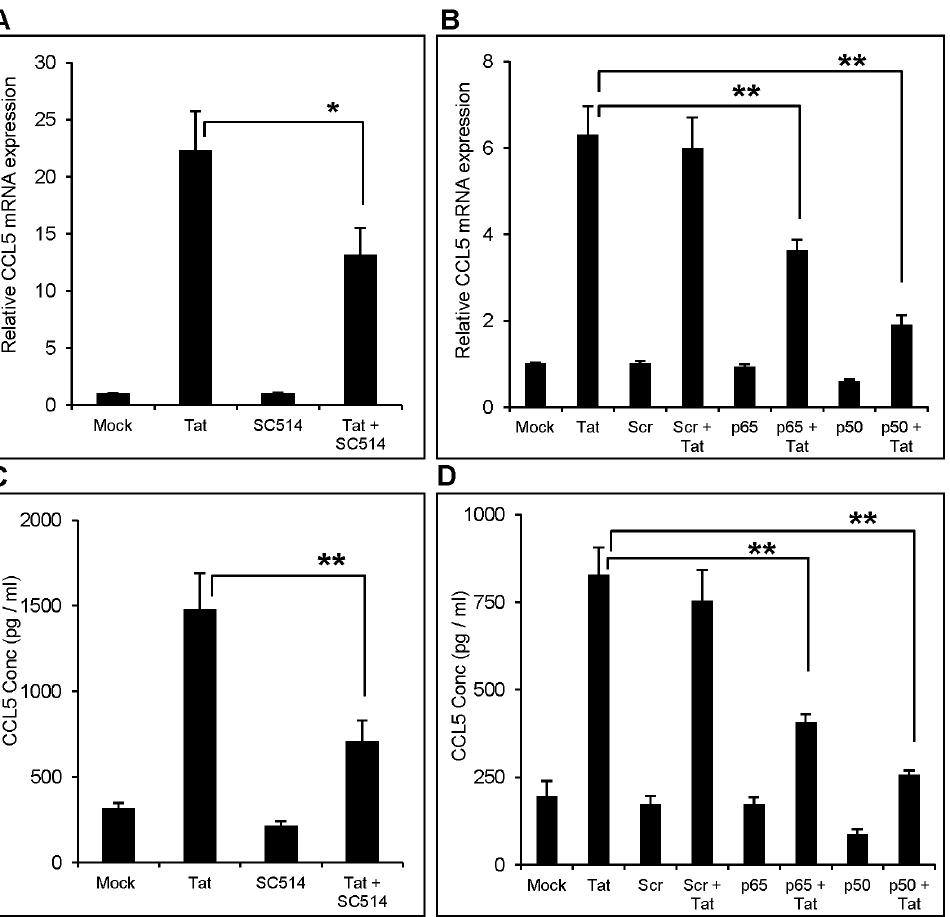
Figure 3. Involvement of NF- k B in HIV-1 Tat mediated production of CCL5 from astrocytes. (A, B) SVGA astrocytes were treated with 10 m M of NF- k B inhibitor (SC514) prior to transfection with plasmid encoding HIV-1 Tat. (C, D) For knockdown using siRNA, the cells were transfected with the siRNA followed by Tat transfection as mentioned in the Materials and Methods. The expression of CCL5 at the mRNA and protein levels were measured at 6 h and 48 h post-transfection by using RT-PCR (A,C) and multiplex cytokine assay (B, D), respectively. The values represented for mRNA are expressed relative to the mock-transfected controls. Each experiment was performed in triplicate and each bar in the figure represents the mean 6 SE of at least three individual experiments. One-way ANOVA was used to perform the statistical analysis and ** denotes p-value # 0.01 and * denotes p-value of # 0.05.